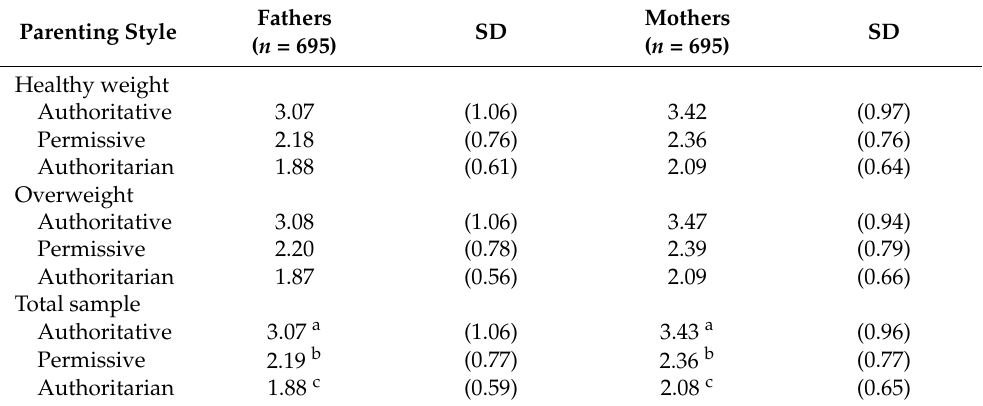
Table 2. Mean and standard deviation of fathers’ and mothers’ perceived parenting styles according to adolescent weight classification, and for the total